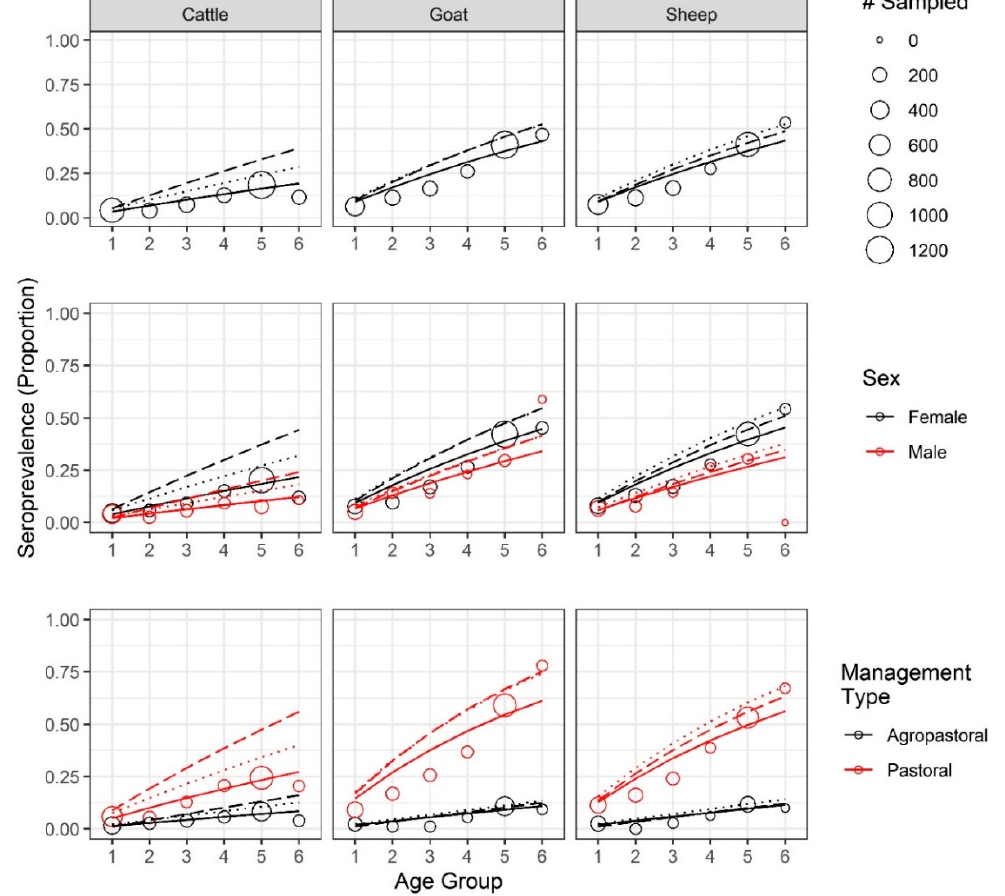
Figure 3. PPRV seroprevalence increases by age for sheep, goats, and cattle. Age–seroprevalence curves by species, sex, and management system. Solid lines indicate the catalytic model fit to the apparent seroprevalence. True seroprevalence adjusted [28] for competitive ELISA antibody test sensitivity and specificity estimates of Couacy-Hymann et al. 2007 [24] and estimates generated in-house (see Methods) are plotted as dotted and dashed lines, respectively.